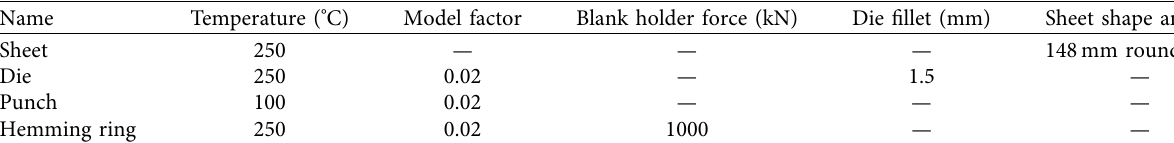
Table 1: Optimized hot drawing process plan.